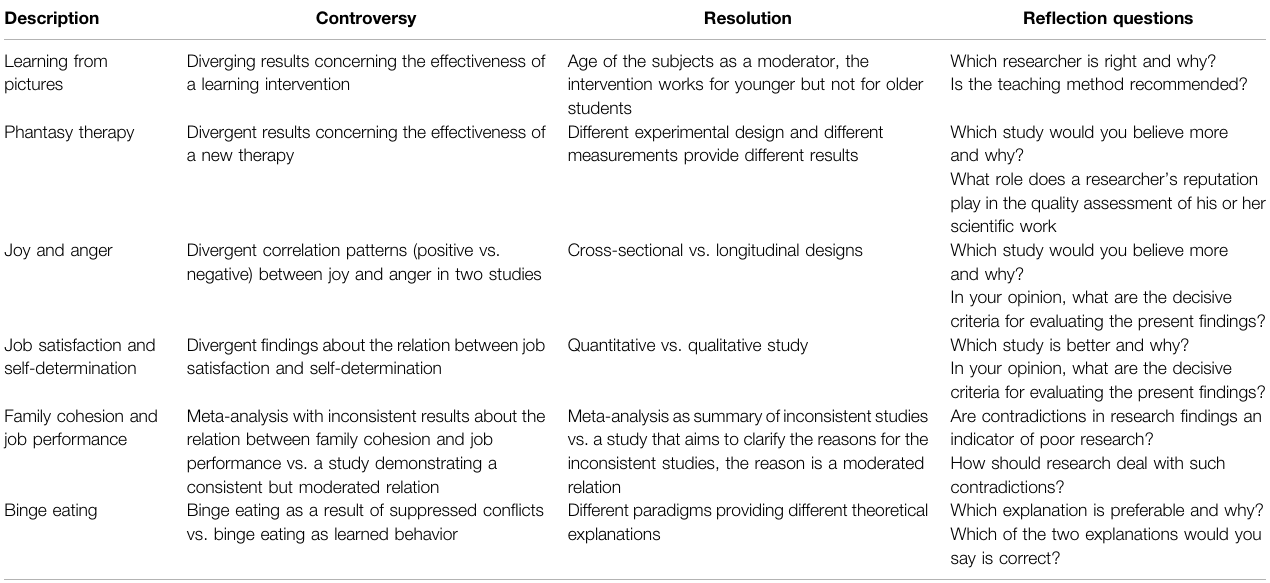
TABLE 2 | Description of the controversies in the